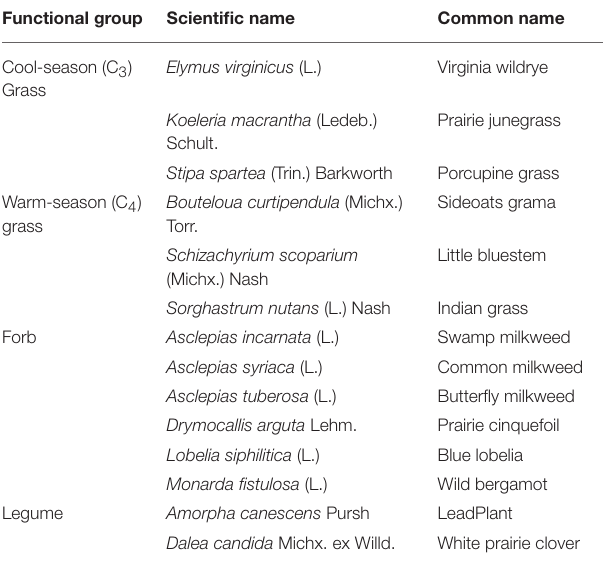
TABLE 1 | Functional groups of modeled